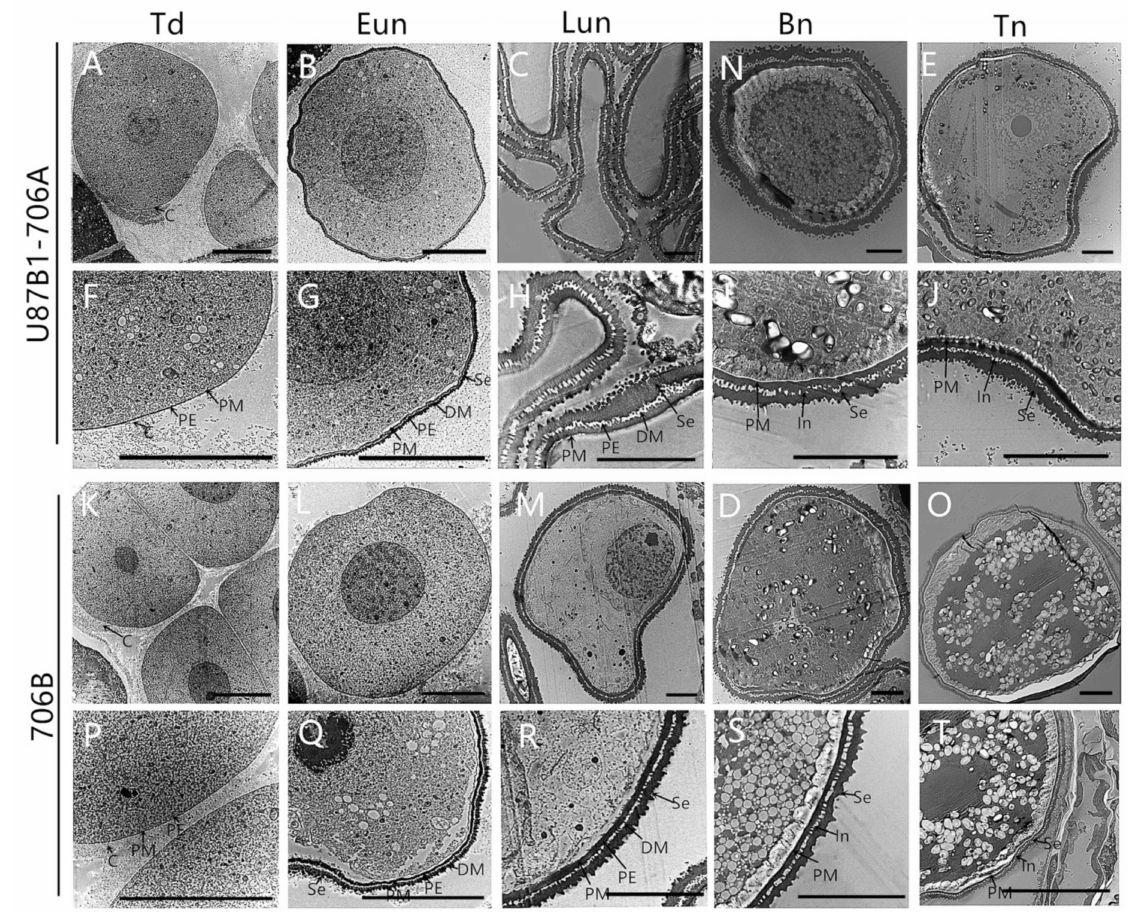
Figure 6. Transmission electron micrographs of the microspores in U87B1-706A ( A – J ) and 706B ( K – T ). ( A , F , K , P ) Td, tetrad stage; ( B , G , L , Q ) Eun, early uninucleate stage; ( C , H , M , R ) Lun, late uninucleate stage; ( D , I , N , S ) Bn, binucleate stage; and ( E , J , O , T ) Tn, trinucleate stage. C, callose; PE, primexine; Se, sexine; DM, deposit materials; PM, plasma membrane; In, intine. Scale bars are 3 µ m in ( A – T